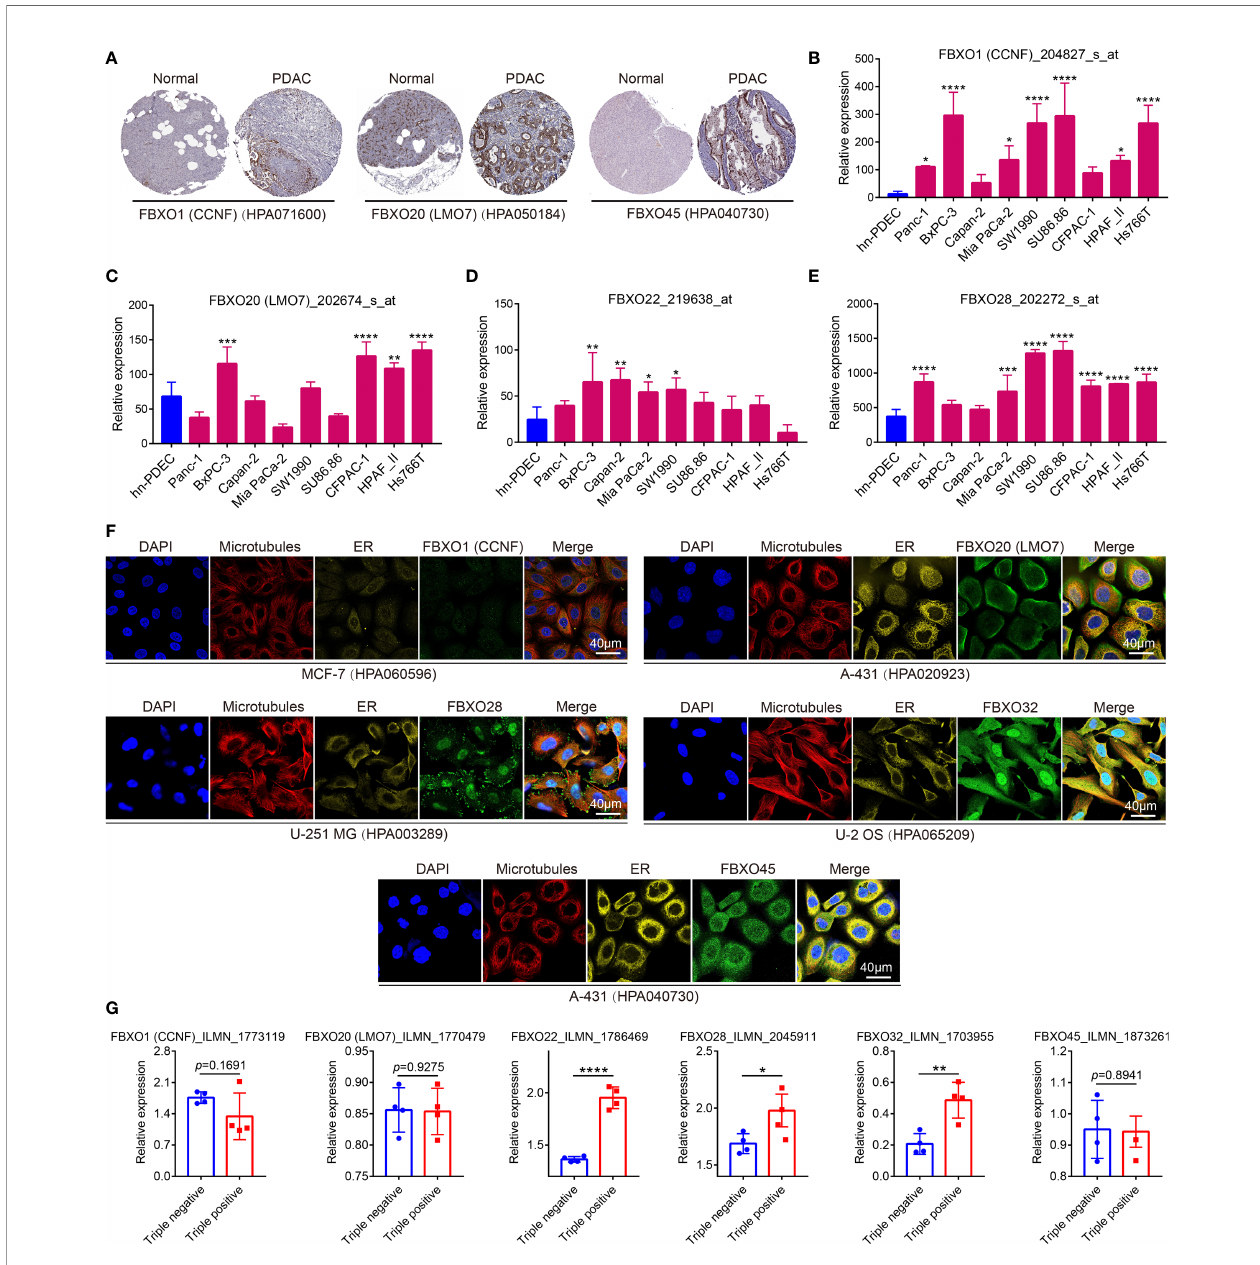
FIGURE 4 | The protein expression, cell lines, cellular localization, and cell stemness of six-FBXOs in pancreatic ductal adenocarcinoma (PDAC). (A) The protein expression of FBXO1, 20, and 45 in PDAC and normal tissues using immunohistochemistry (IHC) in Human Protein Atlas (HPA) database. The IHC images of FBXO22, 28, and 32 were absent. The code behind the gene is the related primary antibody in HPA. (B – E) The expression levels of FBXO1, 20, 22, and 28 in human normal pancreatic ductal epithelial cells (hn-PDEC) and multiple PDAC cell lines using GSE45757 dataset. The code behind the gene is the related probe name. FBXO32 and FBXO45 were not available. (F) The confocal images of cellular localization of six-FBXOs in different types of cells using HPA database. The code behind the cell line is the related primary antibody in HPA. ER, endoplasmic reticulum. (G) The expression levels of six-FBXOs in triple-positive group ( n = 4) and triple-negative group ( n = 4), which were classi fi ed by three key cancer stem cell markers, CD44, CD133, and EpCAM, using GSE51971 dataset. The code behind the gene is the related probe name. * P < 0.05, ** P < 0.01, *** P < 0.001, **** P <